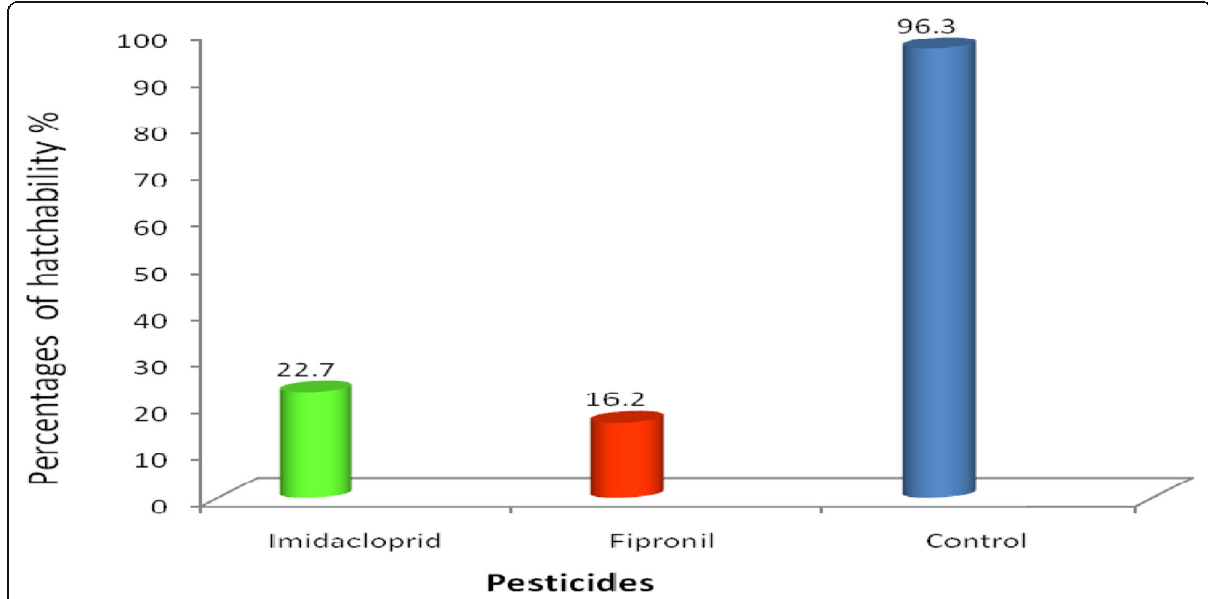
Fig. 2 Effect of the tested pesticides on the eggs hatchability of chocolate banded snail, Eobania vermiculata